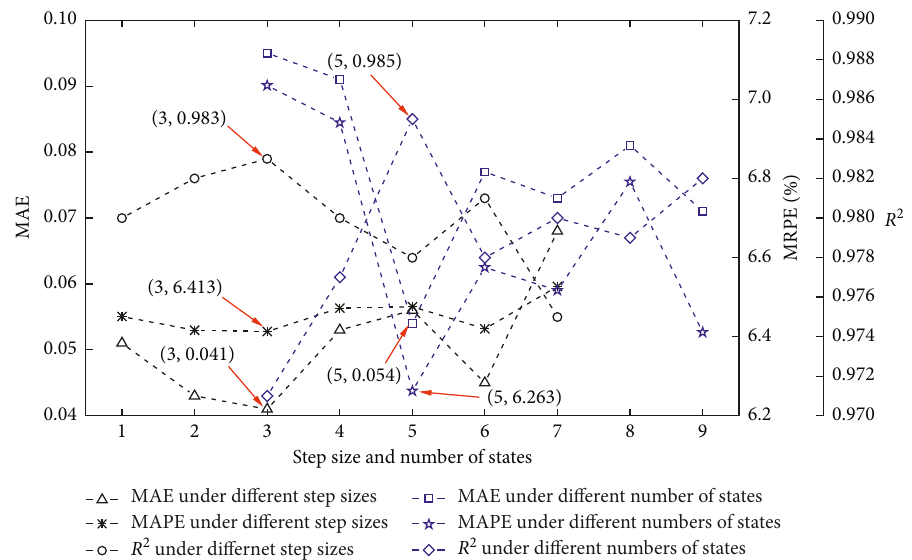
Figure 10: Forecasting accuracy of IGMMW model for training set under different values of model parameters.